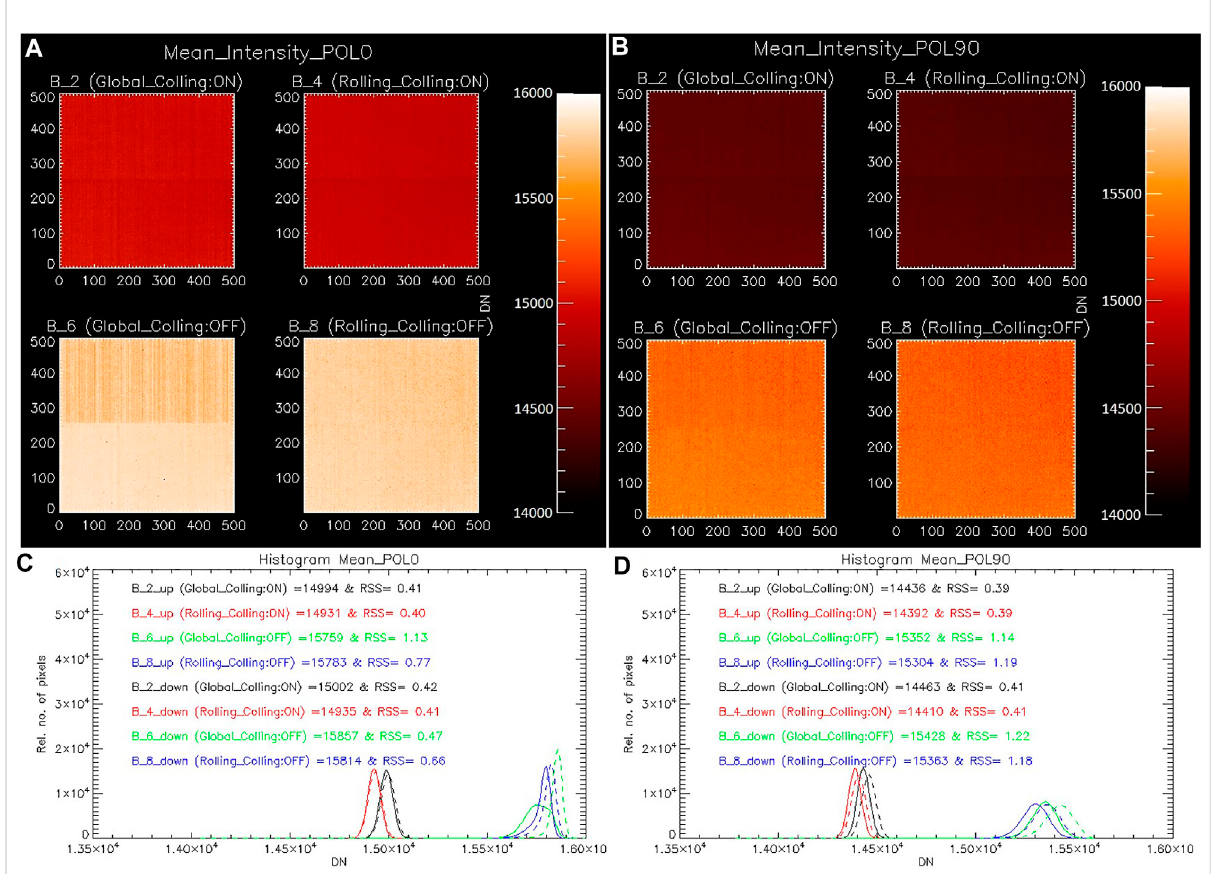
FIGURE 6 Comparison betweenShutter types (Global andRolling) andcooling.Averageof tendifferentexposure times.Data acquired with thereference polarizer.Blocks2and6arefromGlobalShutterandblocks4and8arefromRollingShutter.B2andB4havethecoolingON,B6andB8donot.Panel (A,B) are 2D plots for POL0 and POL90, respectively. Panel (C,D) are histograms of the mean intensity for POL0 and